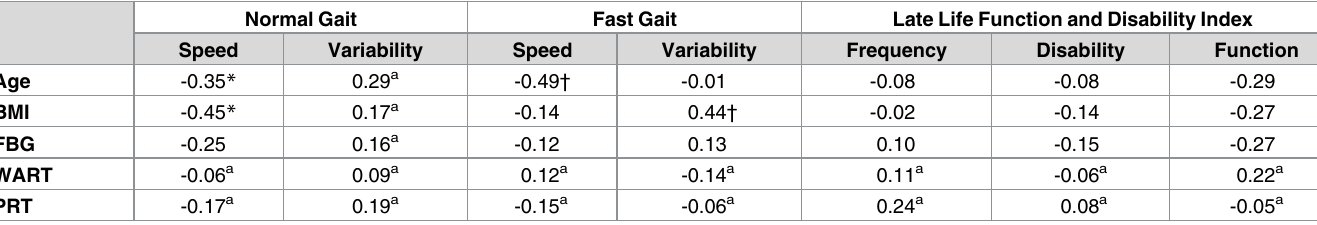
Table 5. Multitasking and other correlatesof gait and functional ability in control